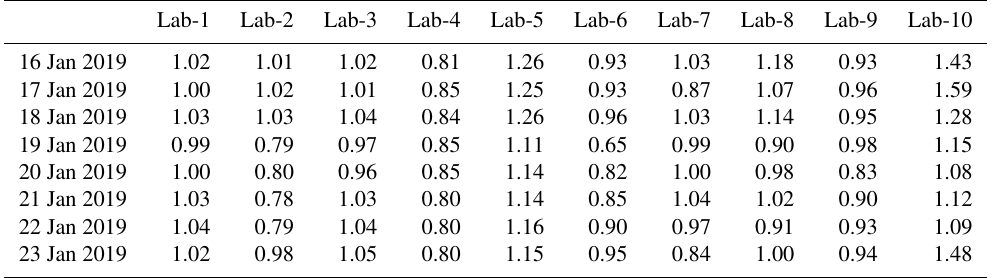
Table 5. Anion and cation equivalent ratios (AE / CE) among the 10 laboratories.